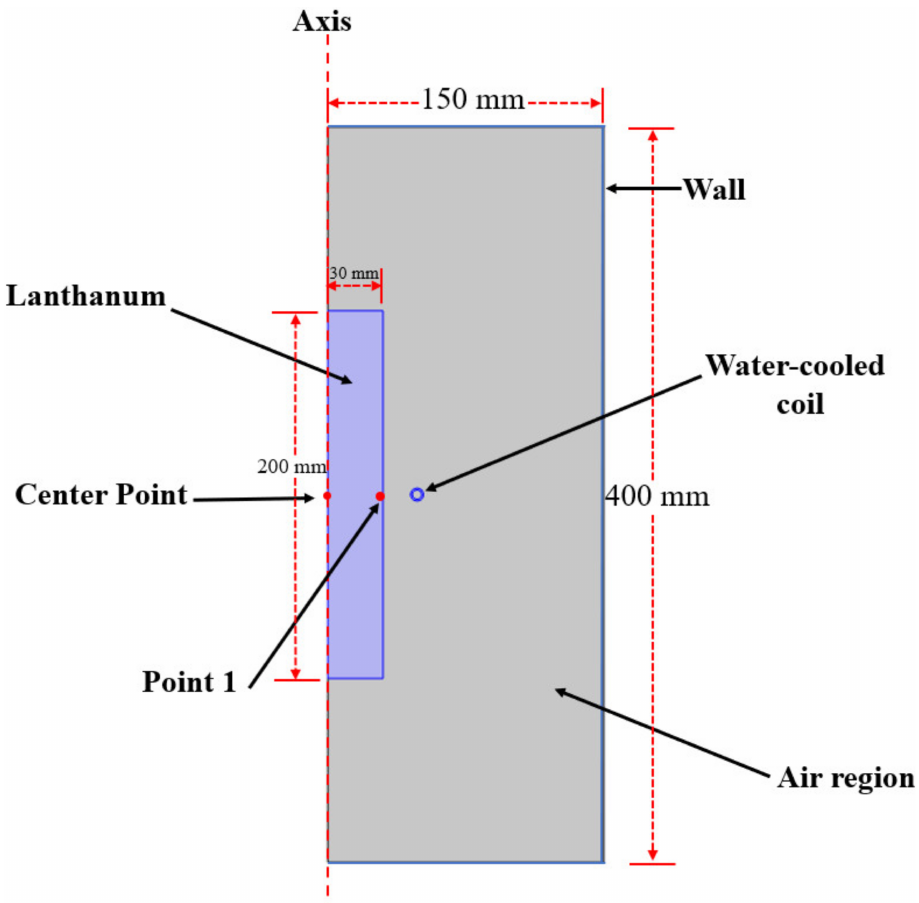
Figure 1. Geometrical model of the zone refining